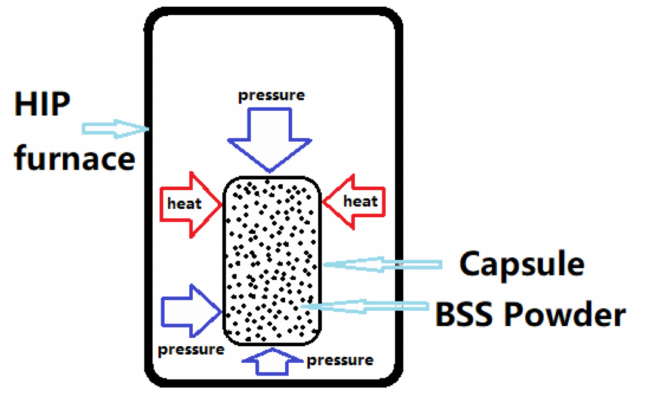
Figure 4. Drawing of HIP (hot isostatic pressing) sintering